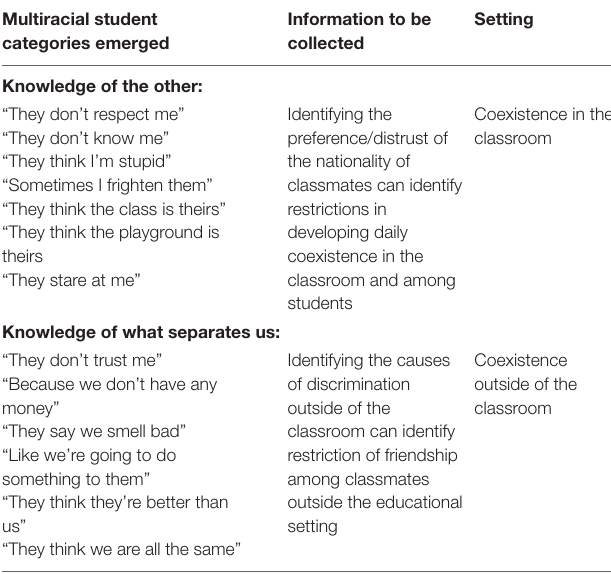
TABLE 2 | Questions asked to detect discrimination in the classroom by students of the mainstream ethnic group. Multiracial student categories